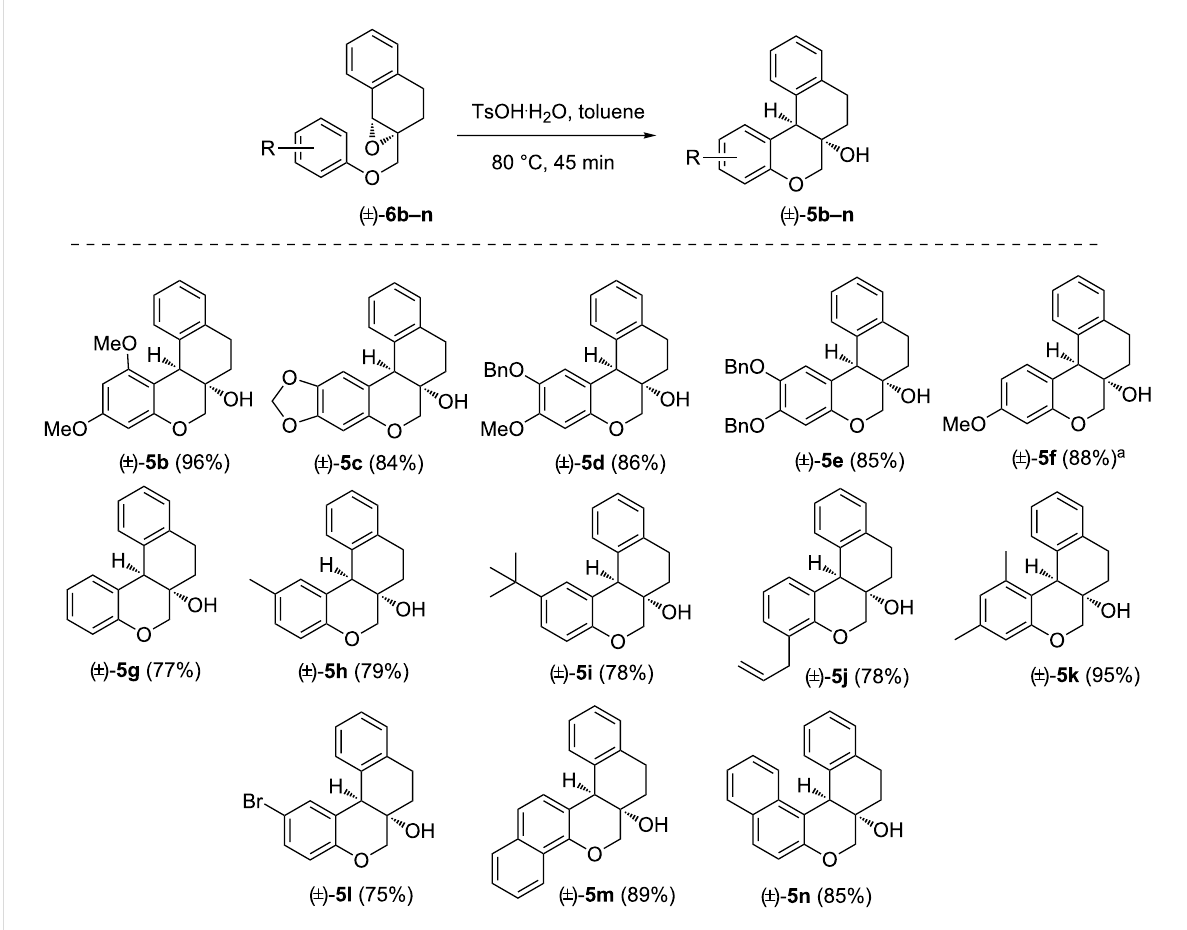
Figure 2: Assessment of the IFCEA cyclization on additional substrates (±)- 6b–n leading to (±)- 5b–n . Reaction conditions: (±)- 6b–h (0.4 mmol), TsOH·H 2 O (20 mol %), toluene (8 mL), 80 °C, 45 min. The numbers in parentheses represent isolated yields after silica gel column chromatography. a Yield of isolated mixture of the inseparable